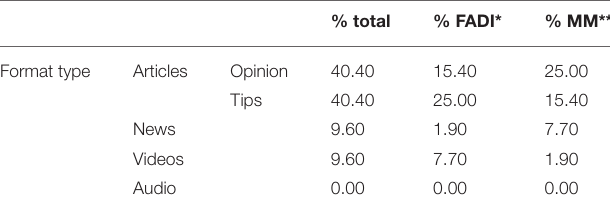
TABLE 4 | Type of format